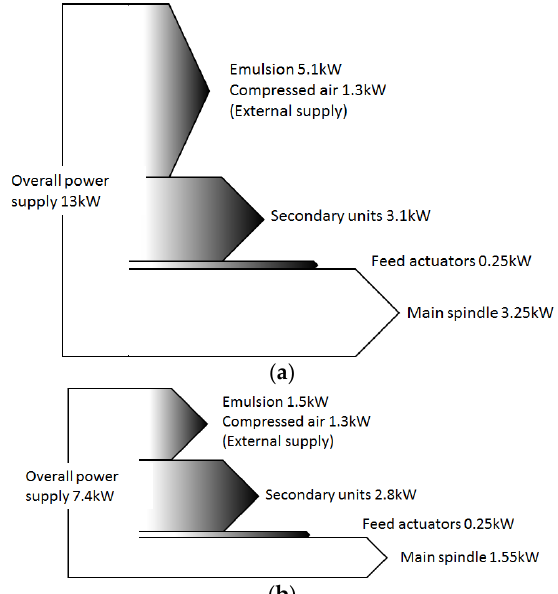
Figure 1. Breakdown of the average power supply needed for the production of a reference component: ( a ) roughing; ( b ) finishing. Gray shaded arrows represent energy consumption shares other than the main spindle of the machine.